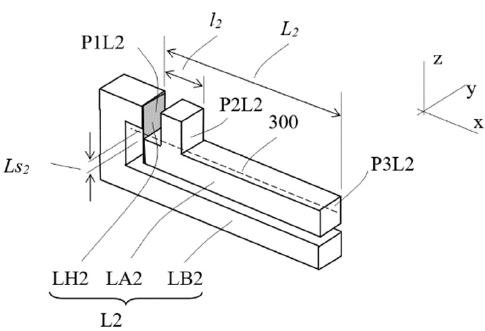
Figure 9. Single lever design of the conceptual design D.